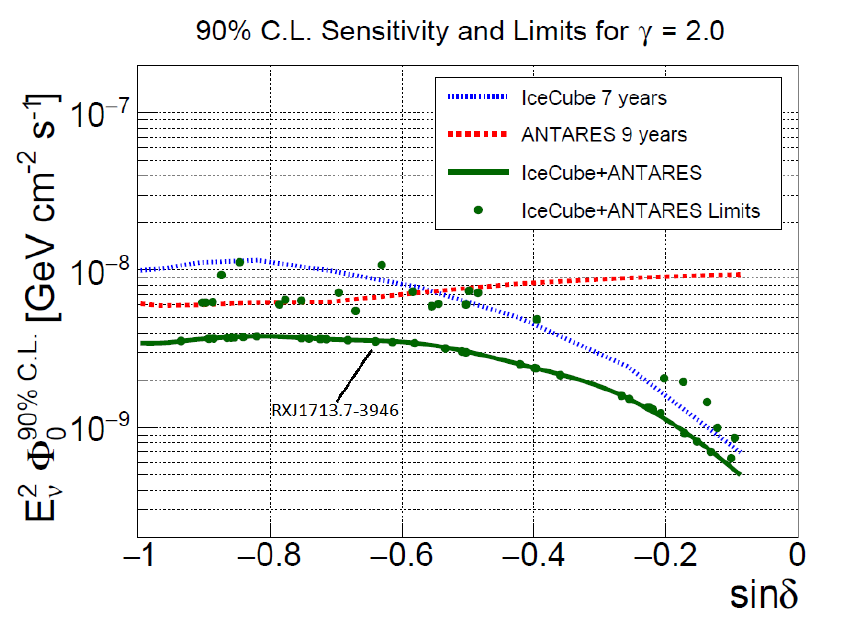
Figure 10. Upper limits at 90% C.L. on the ν µ + ¯ ν µ neutrino flux normalization from 57 neutrino candidate sources (green dots) studied by the ANTARES and IceCube collaborations, as a function of the source declination [92]. Such kind of plots depends strongly on the assumption of the neutrino energy spectrum and on the differential sensitivity of the detectors. The present plot is computed assuming an unbroken neutrino spectrum, with spectral index γ = 2.0. For this spectrum, most of signal is due to neutrinos with E ν > 10 TeV. The green line indicates the sensitivity of the combined analysis. The dashed curves indicate the sensitivities for the IceCube (blue) and ANTARES (red) individual analyses. Referring to Figure 2, the limit corresponding to the SNR RXJ1713.7-3946 is indicated (when comparing the two plots, remember that the y-axis of this figure must be multiplied by 10 − 3 to have the same